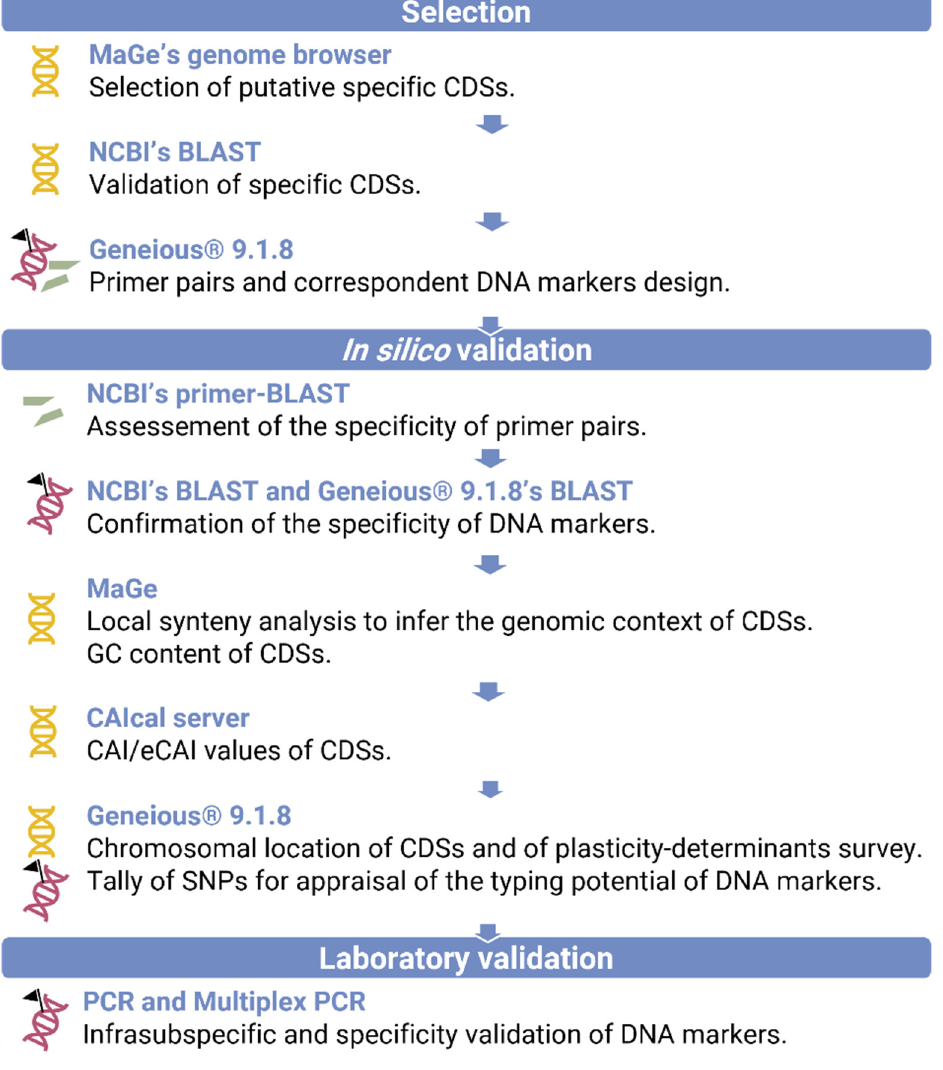
Figure 1. Flowchart for the selection and validation of X. euroxanthea -specific DNA markers.